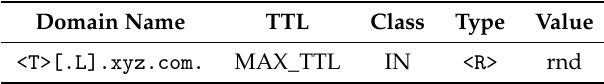
Table 1. Example of pattern record with